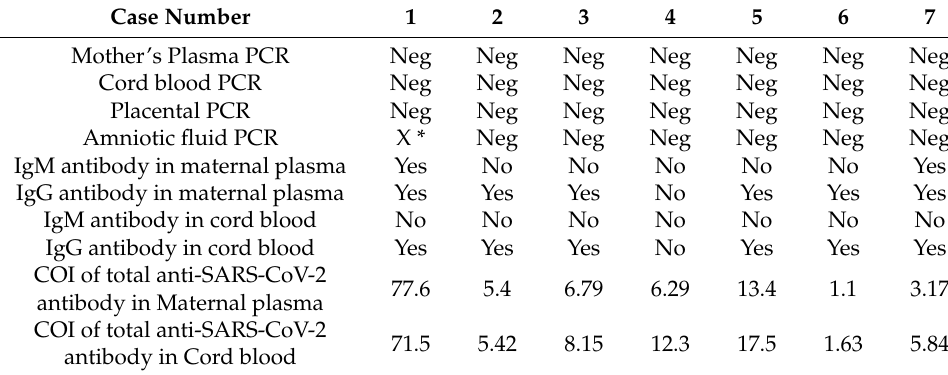
Table 4. Laboratory findings at delivery.